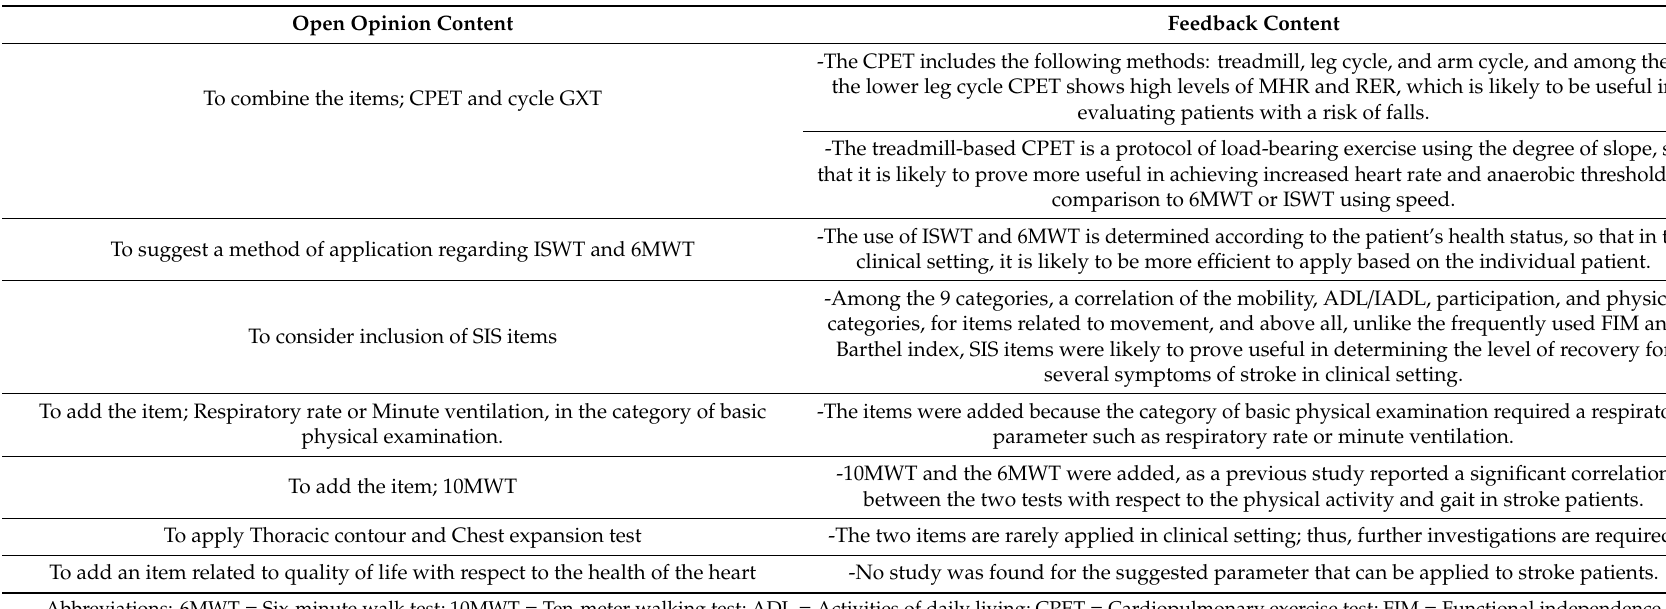
Table 12. Second survey after the second modified Delphi investigation, open opinions, and researcher